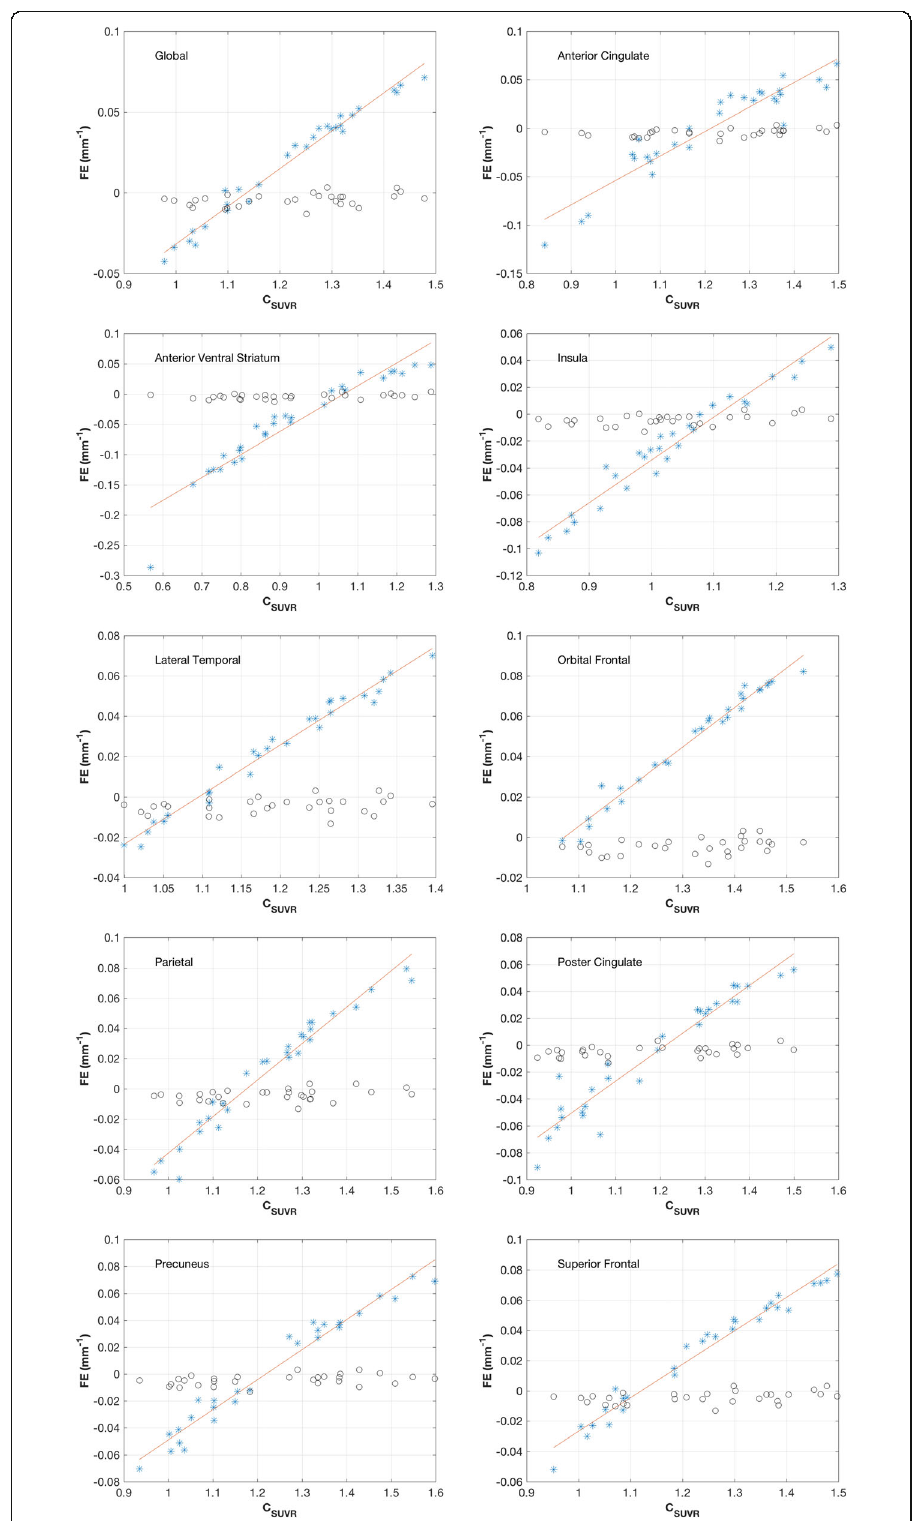
Fig. 2 (See legend on next